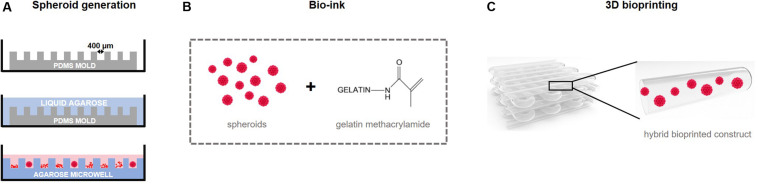
Experimental study design. (A) Printable micro building blocks (spheroids) for the creation of a larger construct are generated in high-throughput using non-adhesive microwells. Agarose microwells are created by using a PDMS mold as a negative replica. After seeding, cells lower into the pores of the microwell and self-assemble into 3D cellular spheroids. (B) Spheroids are combined with a hydrogel precursor solution, a methacrylamide-modified gelatin for (C) 3D bio-ink based bioprinting of a construct using extrusion.